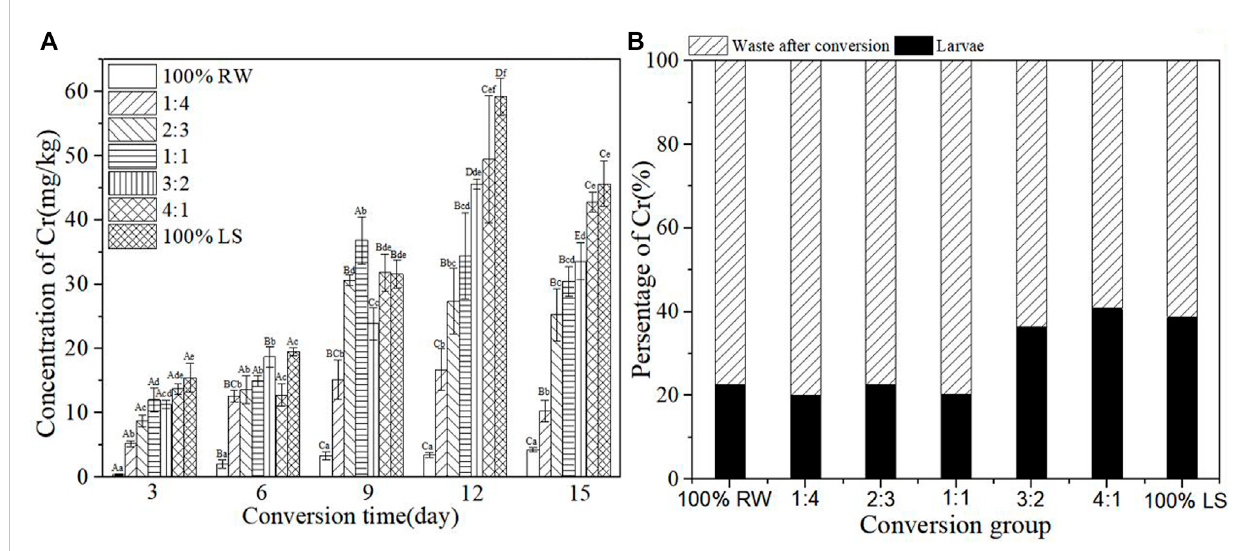
FIGURE 5 (A) : Concentration of heavy metal Cr in BSFL during the conversion; (B) : Percentage of Cr in larvae and waste after conversion. 100% LS:100% lake sediment, 100% RW:100% restaurant waste. The small letters in the Figure 5A indicate the signi fi cance of heavy metal content in BSFL in different groups at the same time. Capital letters indicate the signi fi cance of heavy metal content of the same group at different times (n=3; P >